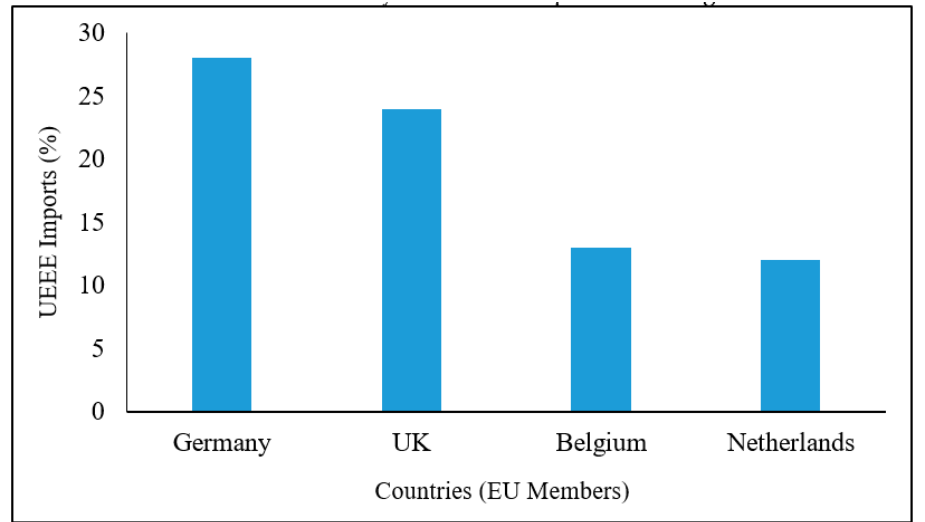
Figure 2. Imported UEEE loaded in vehicles sent to Nigeria from EU countries. Adapted from Balde et al. [150].